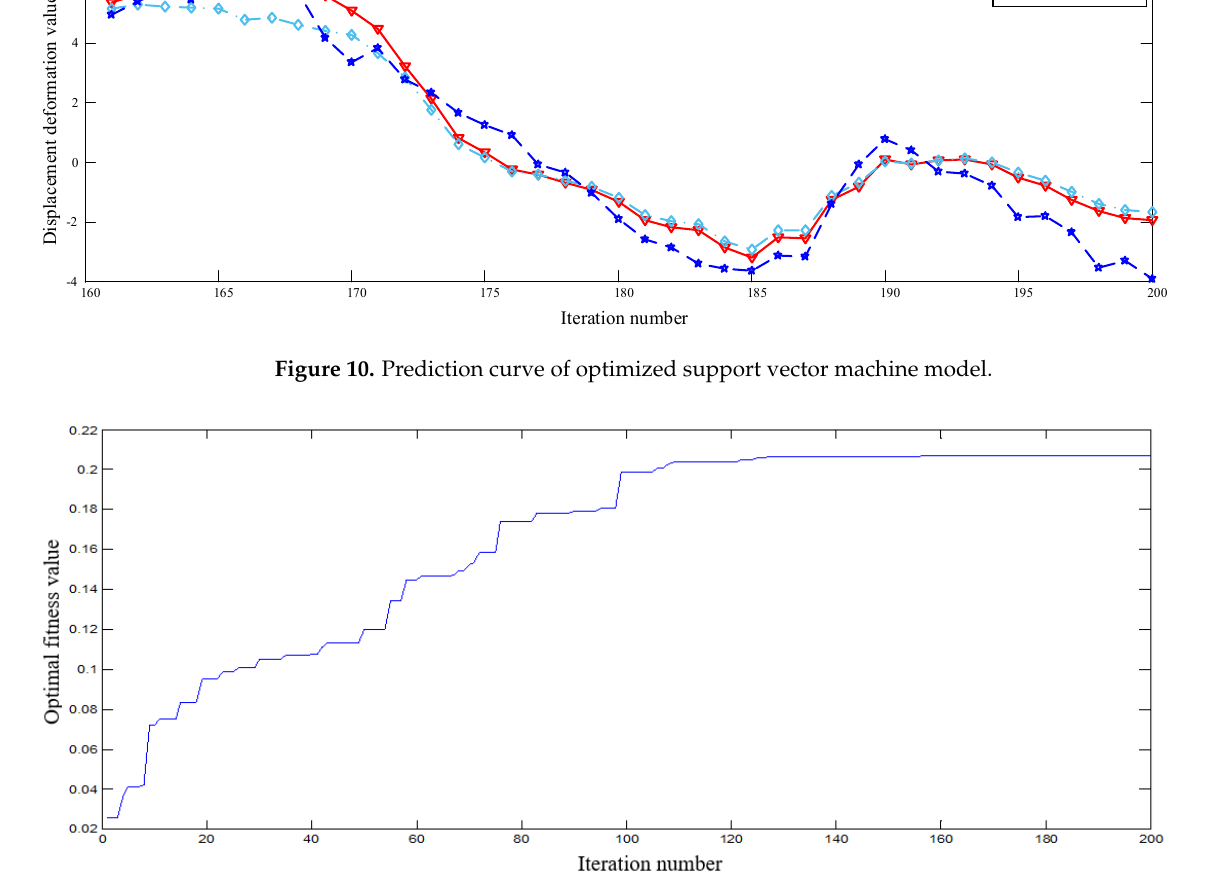
Figure 11. Optimization process of GA optimal fitness value.